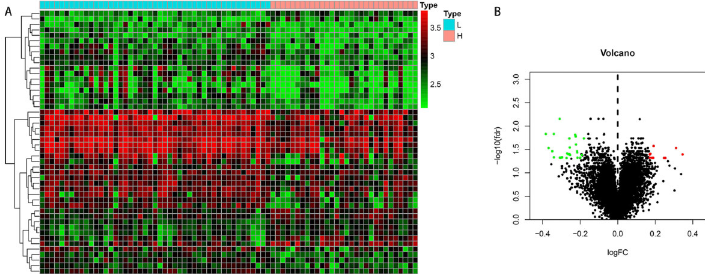
Figure 1. A , Heatmap of signi fi cantly differential genes (SDGs) expression pro fi les in low-grade and high-grade head and neck carcinoma (HNC) samples. The red color indicates the up-regulated genes and green indicates down-regulated genes. L: low-grade; H: high-grade. B , Volcano plot of SDGs in low-grade and high-grade HNC samples. The red dots represent upregulated genes, and the green dots represent downregulated genes.